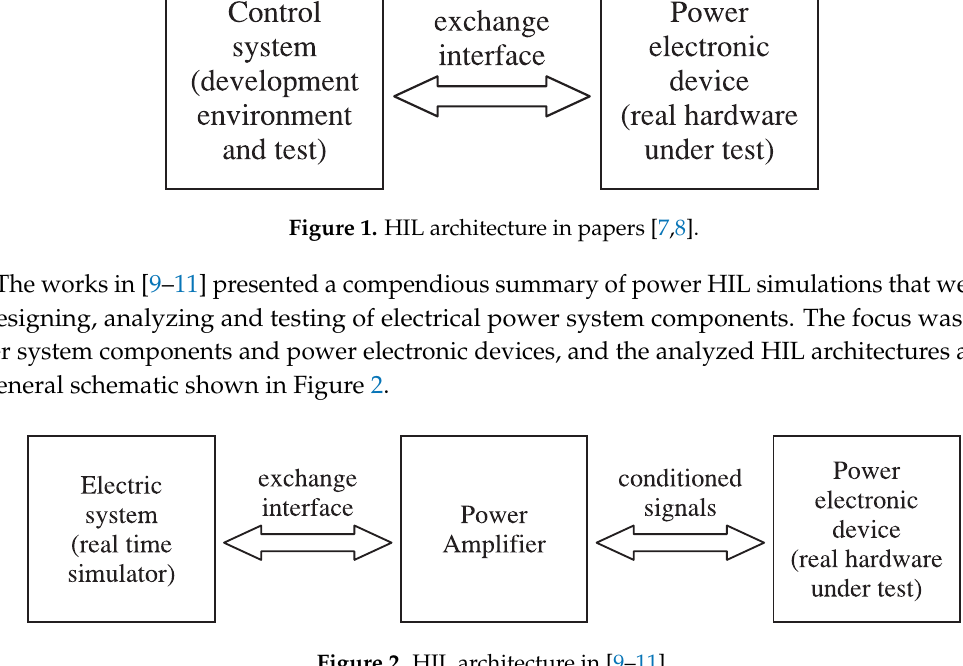
Figure 2. HIL architecture in